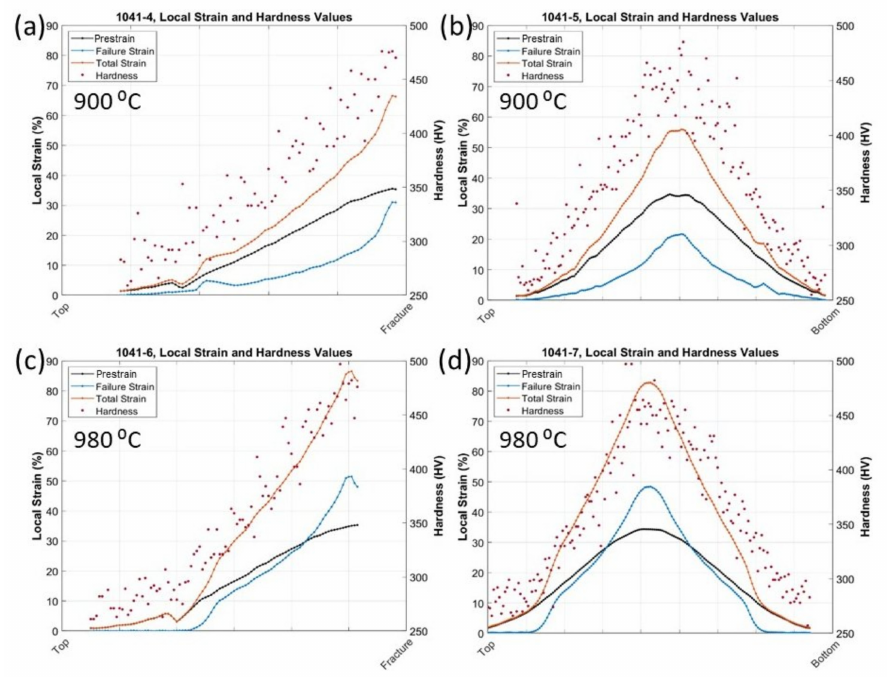
Figure 12. Local strain and micro hardness value correlation. Figures ( a , b ) show specimens that that underwent heat treatment at 900 ◦ C, and Figures ( c , d ) show specimens that underwent heat treatment at 980 ◦